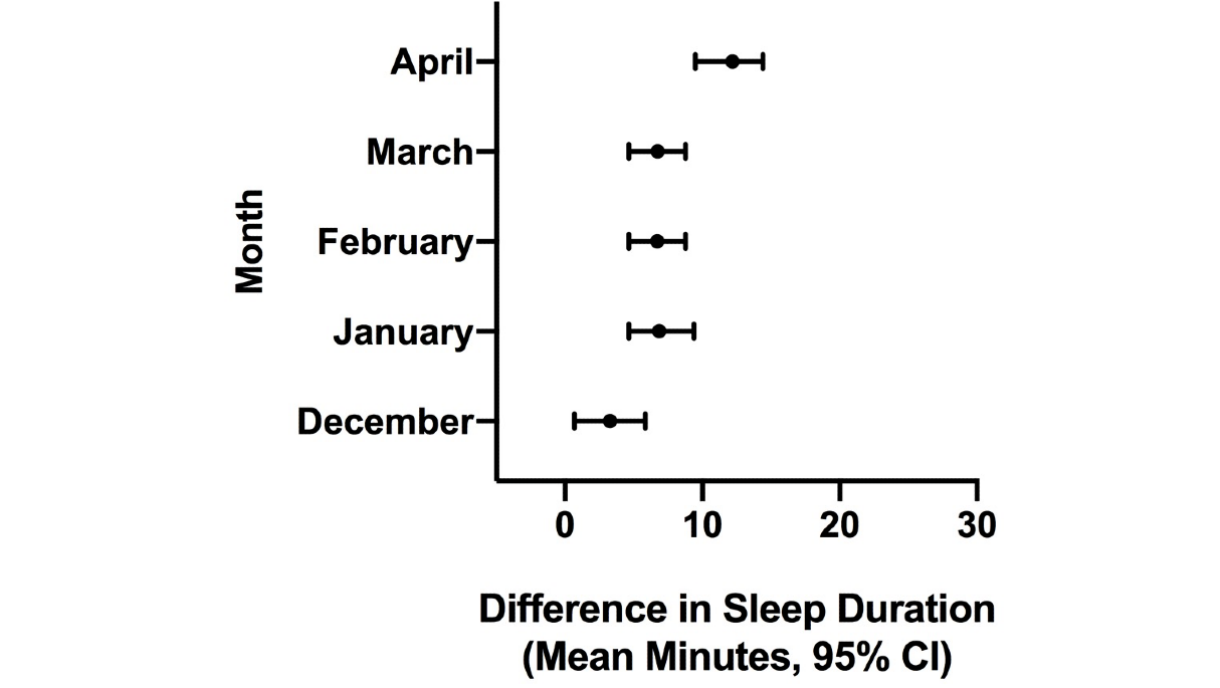
Figure 7. Difference in estimated sleep duration during the COVID-19 pandemic compared to the same month in the previous year in